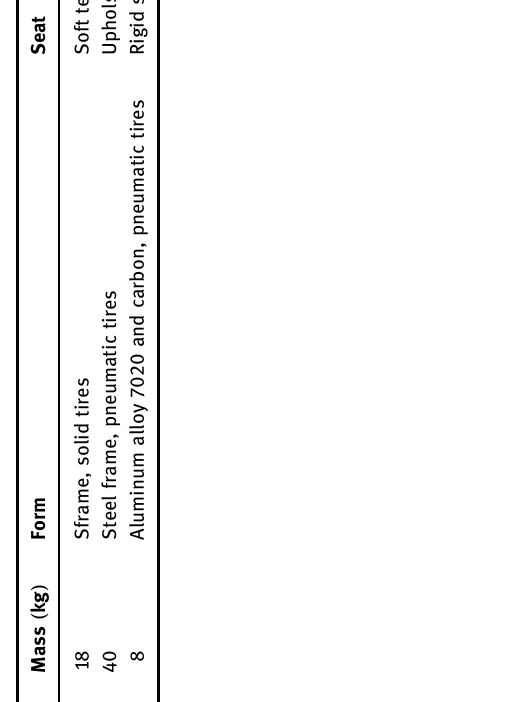
Figure 5: Amplitude – frequency characteristic ( “ Z ” direction ) for the passage of a disabled person in an active wheelchair on the ana - lyzed surfaces against the background of the criterion curve de fi ning the comfort limit according to ISO [ 5 ]